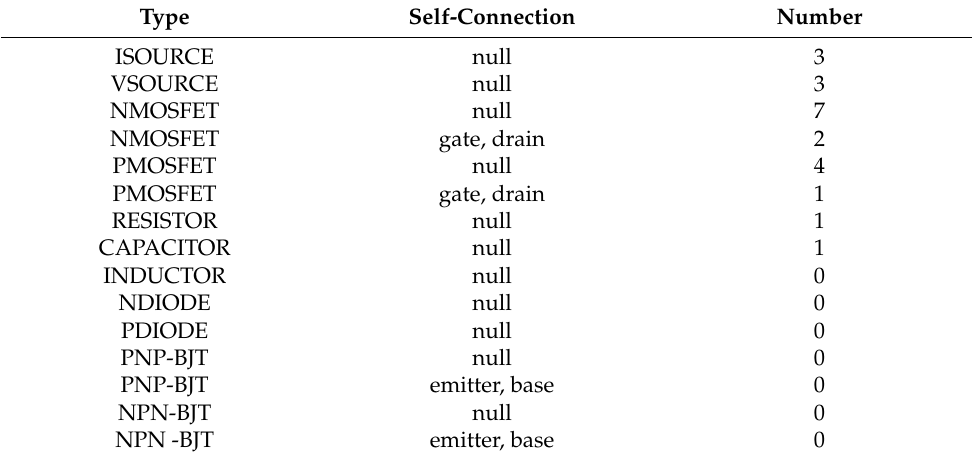
Table 2. Component